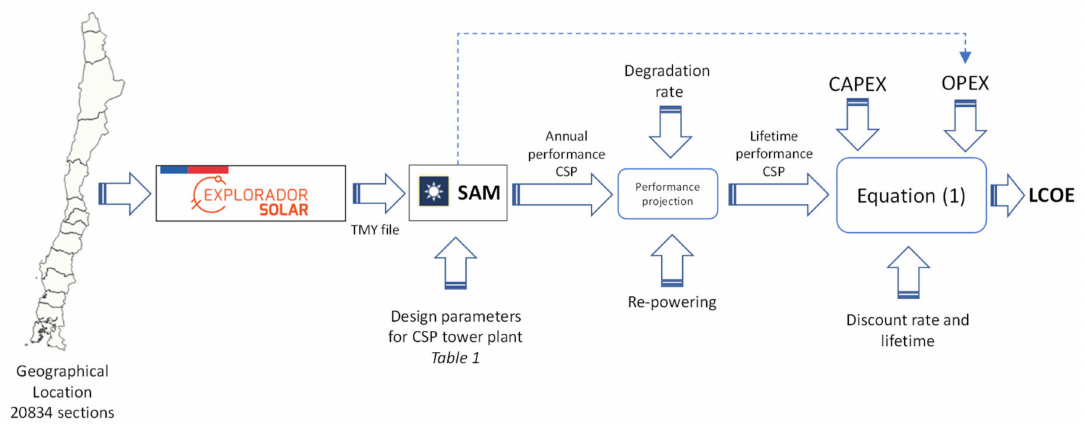
Figure 1. Methodology for levelized cost of electricity (LCOE) map